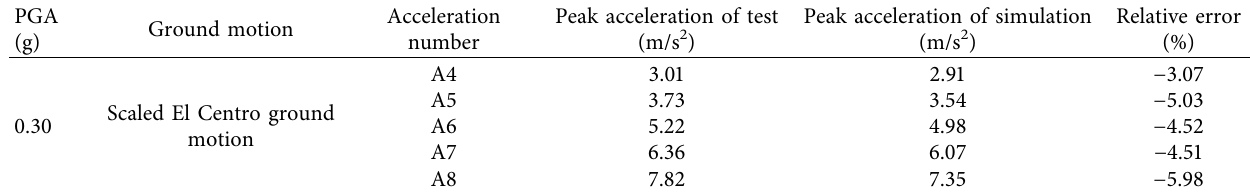
Figure 17: Comparison of acceleration of A5 under 0.30g scaled El Centro ground motion. (a) Acceleration time history. (b) Fourier spectrum. Table 11: Comparison of peak acceleration between test and